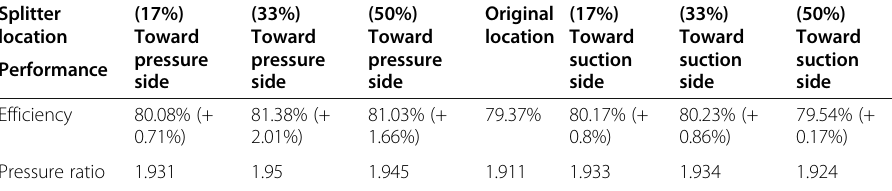
(17%) Toward pressure side 0.71%)